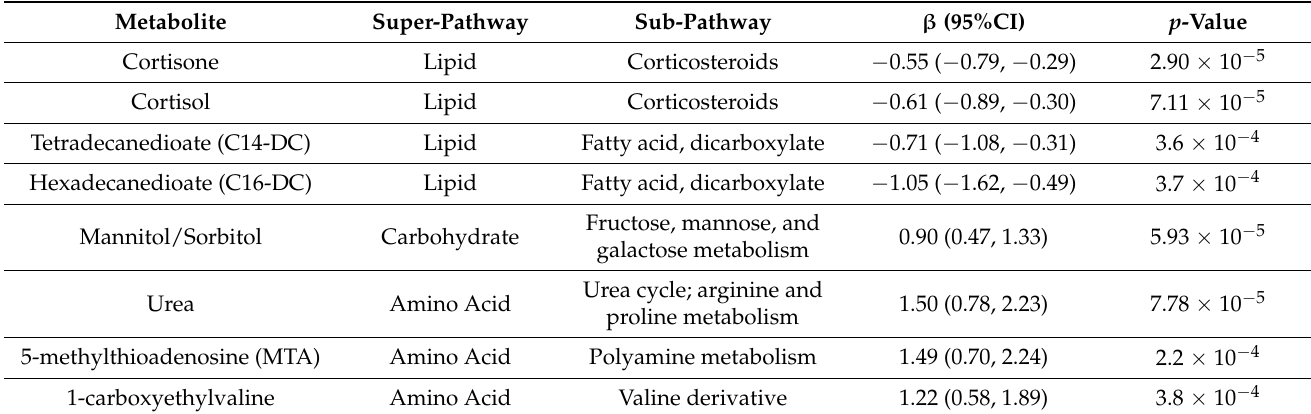
Table 2. Metabolite (predictor) associations with exacerbation (outcome) in asthma cases with inhaled corticosteroid (ICS) intake at an “effective number of tests” (ENT)